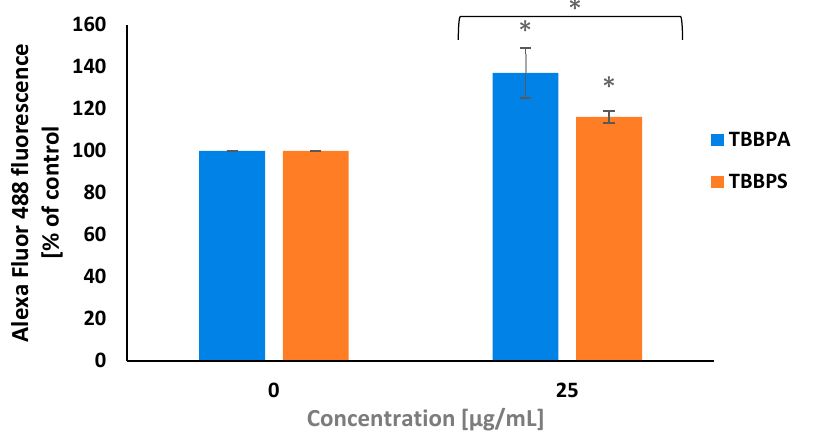
Figure 5. Changes in the level of 85 kDa PARP1 fragments in PBMCs treated with TBBPA and TBBPS at 25 µ g/mL (n = 3) for 24 h. Statistically different from negative control at * p < 0.05. Statistical analysis was conducted using Welch’s test.